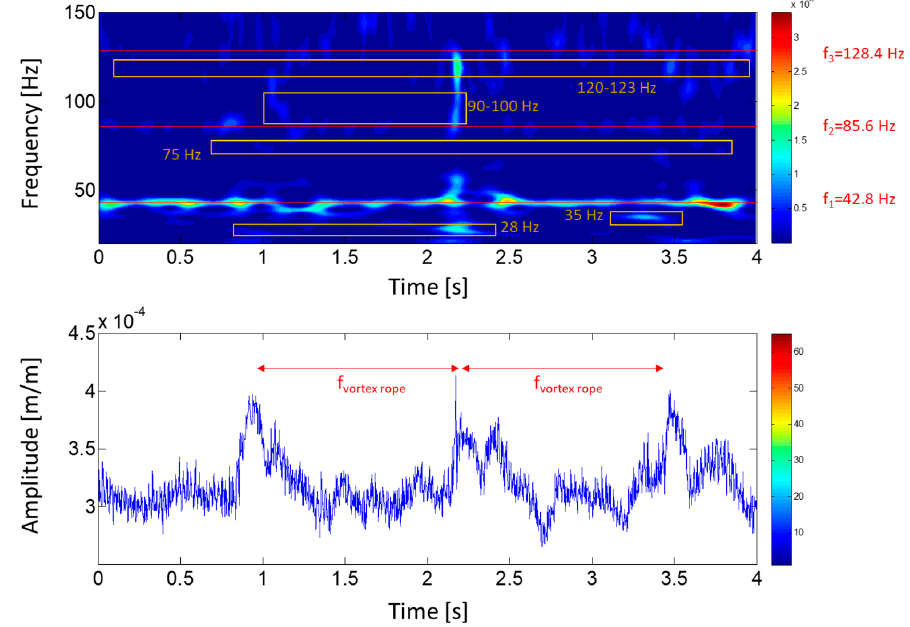
Figure 13. Joint time–frequency plot of a strain-gauge signal (crown side, pressure side, blade 7) during overload (OL) condition (107% of rated power).